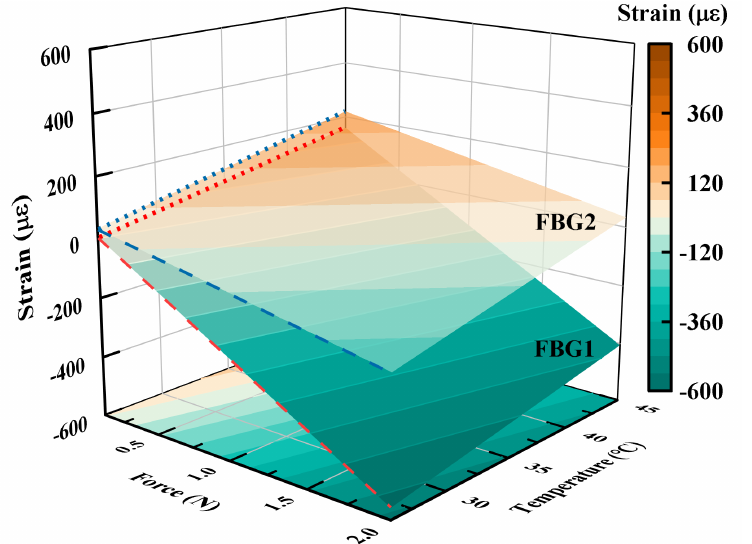
Figure 6. The relation between applied force and temperature and the strain of the two FBGs configured inside the